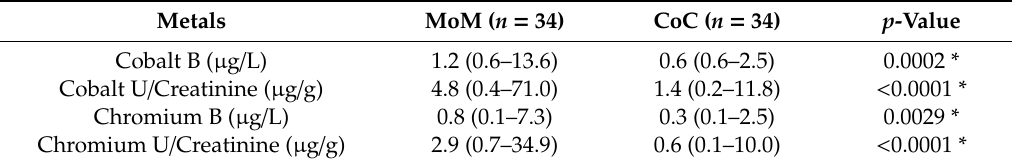
Table 4. Whole blood and urine cobalt and chromium